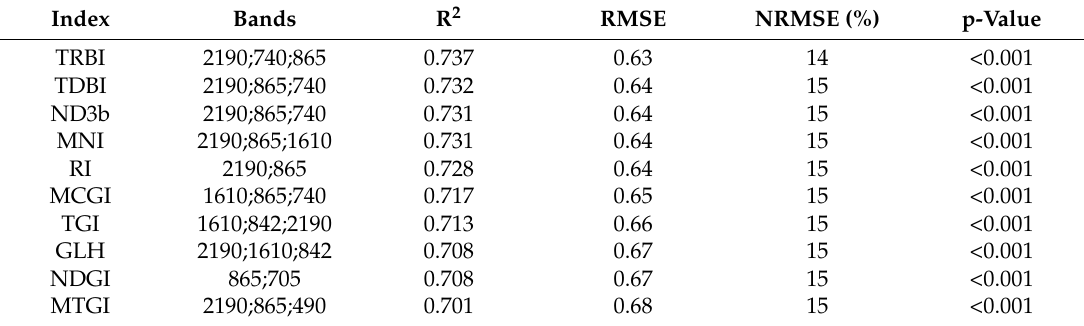
Table 5. Best band combination for each generic vegetation index introduced in ARTMO from cross-validation of the testing dataset (VLC17_ES), ordered from highest to lowest R 2 , with a linear fit.